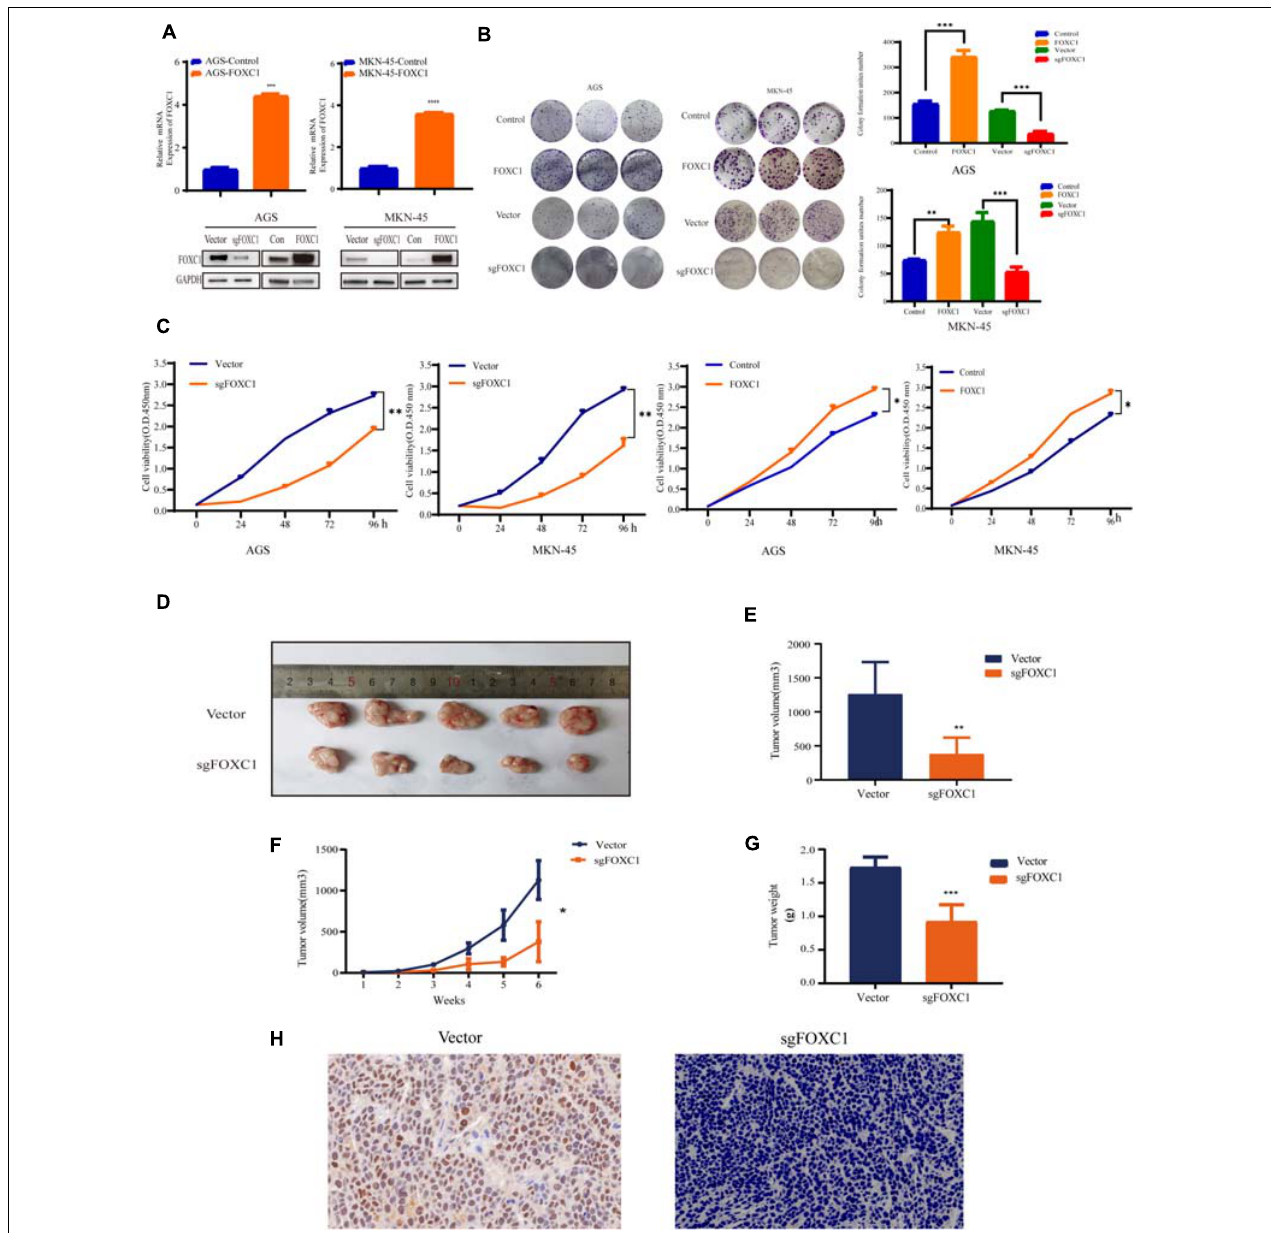
FIGURE 2 | FOXC1 contributes to gastric cancer growth in vitro and in vivo . (A) Verification of overexpression in AGS and MKN-45 cells using qPCR. FOXC1 knockout and overexpress efficiency was confirmed using western blotting, and GAPDH was used as an internal control. (B,C) The impact of FOXC1 expression in vitro on GC cell proliferation, as assessed using colony formation assays (B) . (C) CCK-8 proliferation assays in FOXC1 KO and overexpress AGS and MKN-45 cells, respectively. All CCK-8 assays were performed three times and showed the same trend and representative results were shown in panel (C) . (D–G) MKN-45-Vector and MKN-45-sgFOXC1 cells were injected subcutaneously into right forelimb five nude mice, respectively (5 × 10 6 cells for each mouse). Tumor size (D) , tumor volume (E) , tumor growth curves (F) , tumor weights (G) and IHC (H) are shown ( ∗ P < 0.05, ** P < 0.01, *** P < 0.001, **** P <